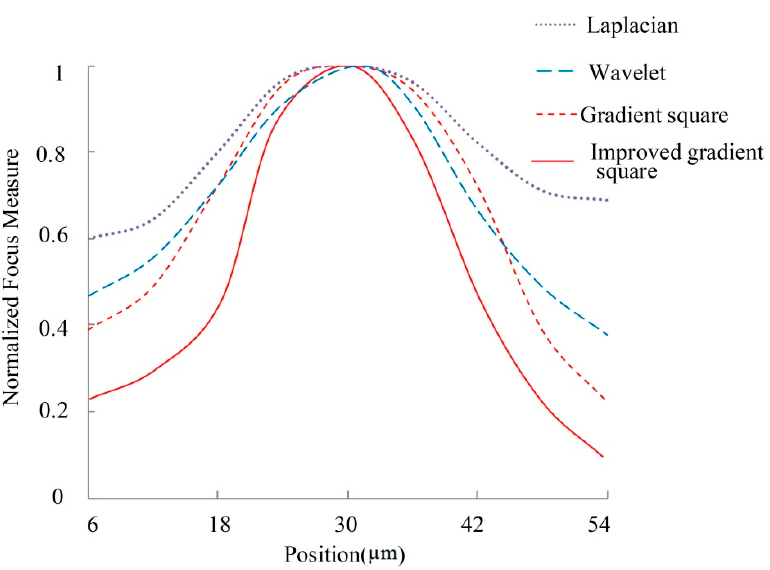
Figure 8. Comparison of focusing curves for different algorithms used in the proposed system.